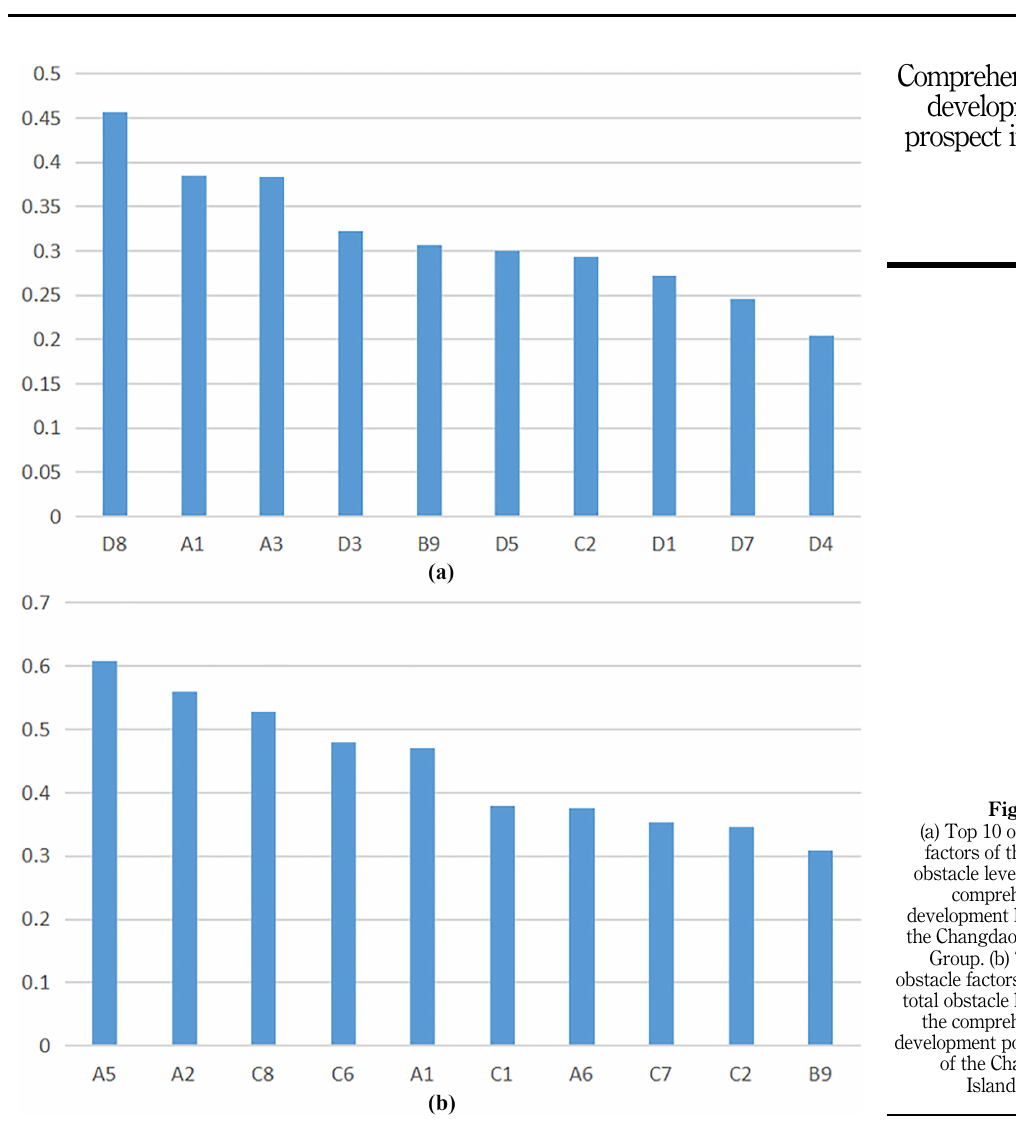
Figure 8. (a) Top 10 obstacle factors of the total obstacle level of the comprehensive development level of the Changdao Island Group. (b) Top 10 obstacle factors of the total obstacle level of the comprehensive development potential of the Changdao Island